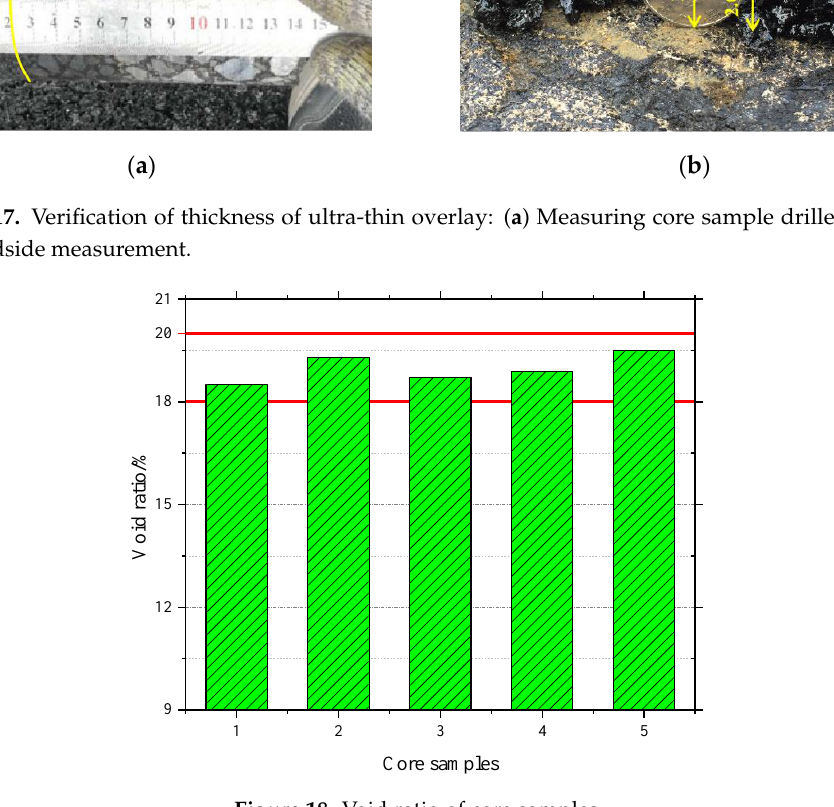
Figure 18. Void ratio of core samples.